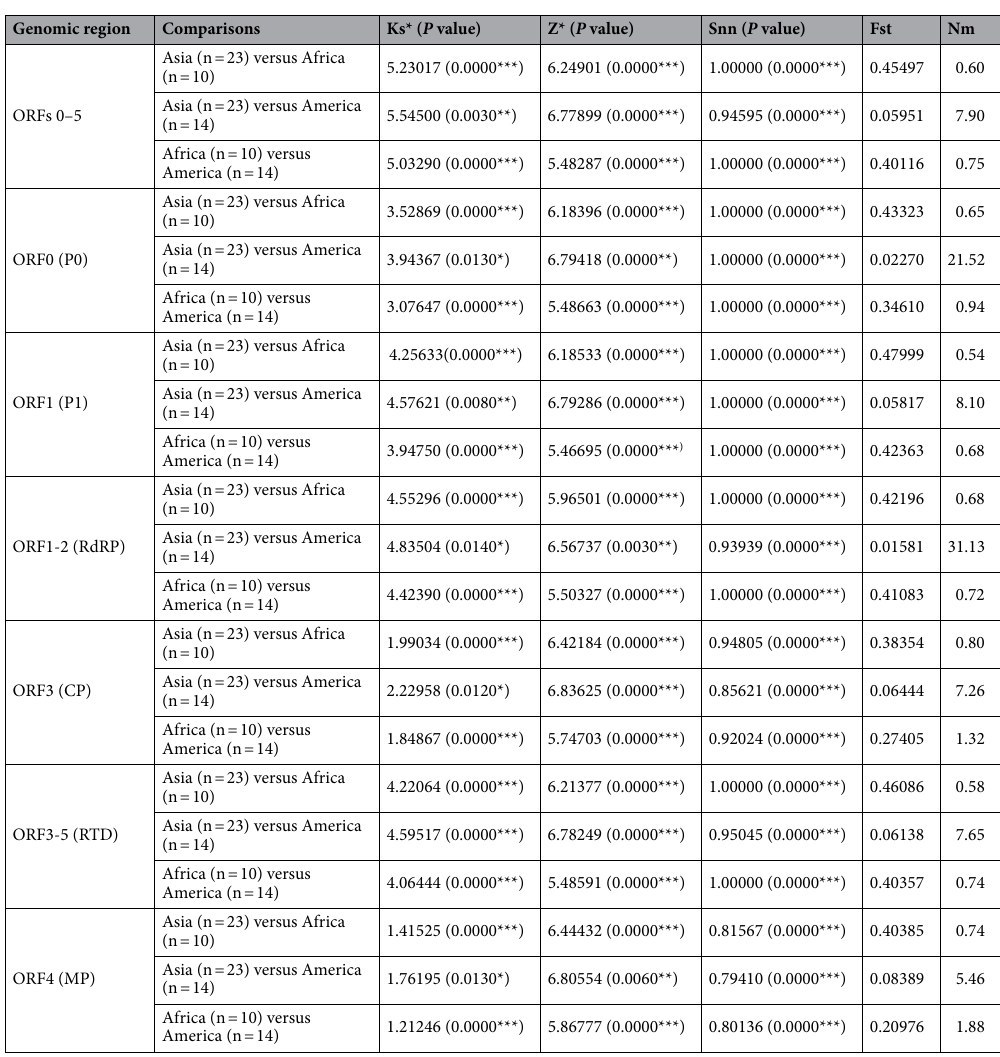
Table 3. Gene flow and genetic differentiation among sugarcane yellow leaf virus (SCYLV) subpopulations based on geographic origins. Symbols are showed for three permutation statistical tests of Ks*, Z*, and Snn